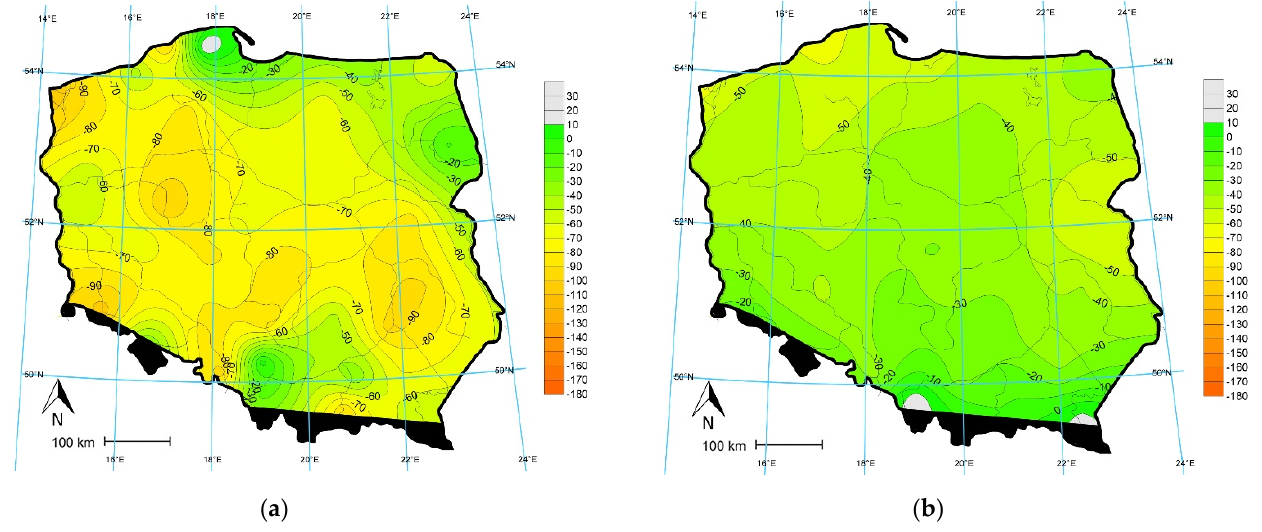
Figure 5. Climatic water balance (CWB) in July: ( a ) 2019; ( b ) 1981–2010. Explanation same as in Figure 2.